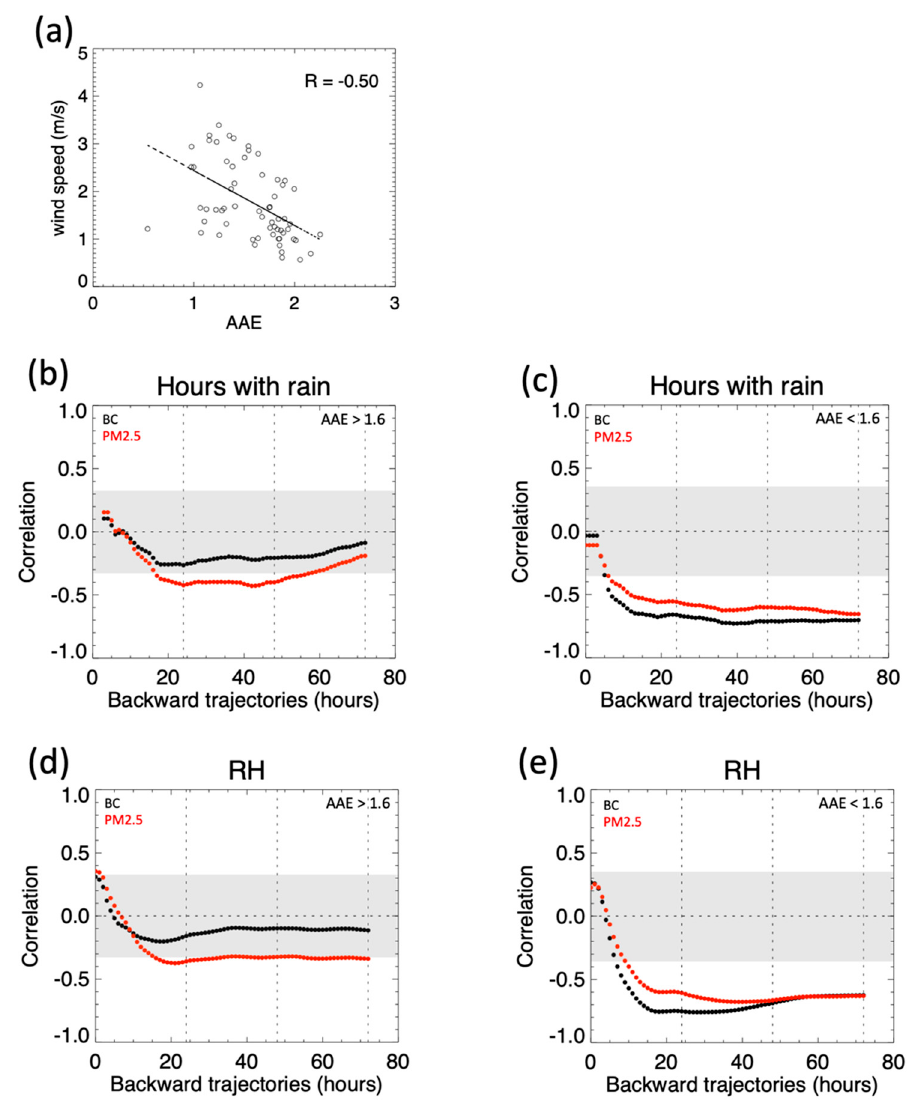
Figure 7. Scatter plot of the wind speed and AAE values for days with an AE > 1 and low RH ( a ). Correlations of accumulated hours with rain ( b , c ) and average RH ( d , e ) calculated over the increasing time range of the backward trajectories, with respect to BC (black) and PM2.5 (red) values recorded at Chiba University. For each trajectory, averages (or sums) were calculated from Chiba University to the indicated hour in 1-h time intervals. The vertical dashed line highlights the 24, 48, and 72-h time periods. Data outside of the gray box (with p -values < 0.05) were statistically significant. Panels ( b , d ): days with an AAE of >1.6; panels ( c , e ): days with an AAE of <1.6. Only clear sky days as recorded at Chiba were considered (i.e., very few rainy events occurred within the first hours). In panel ( a ): R = − 0.34 for days with an AAE of >1.6 and R = 0.10 for days with AAE of <1.6.